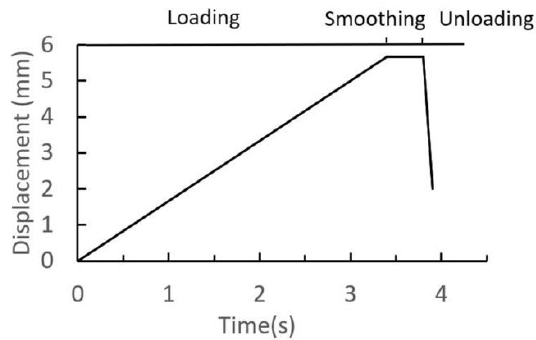
Figure 7. Time-displacement curve of the riveting